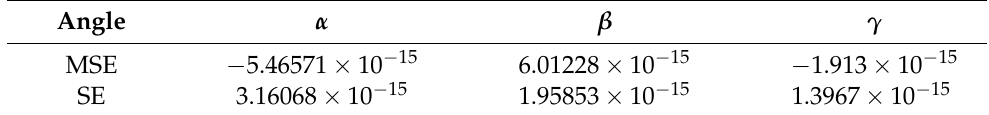
Table 17. Mean Squared Error (MSE) and Standard Error (SE) of